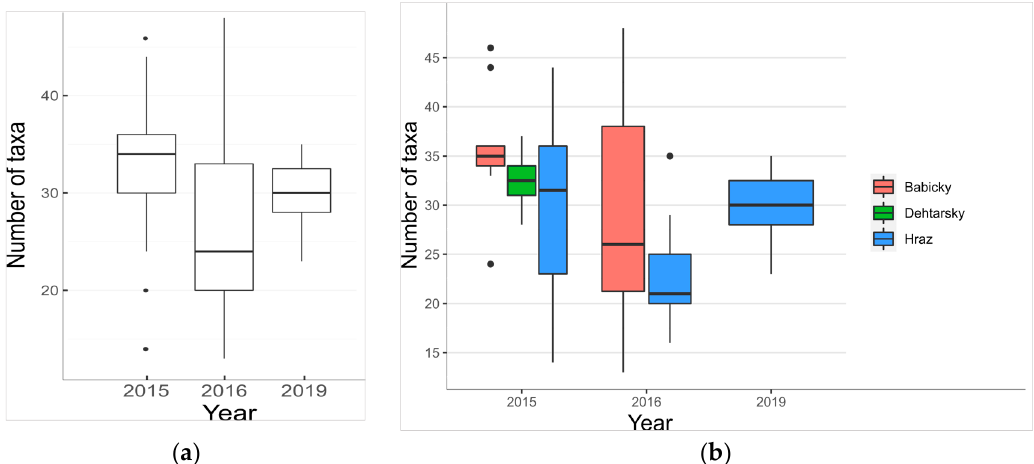
Figure 9. Comparison of diatom species richness in the Dehtá ř fishpond. ( a ) Differences between years; ( b ) differences between years and sites. Median values (horizontal lines), lower and upper quartiles (boxes, i.e., 50% of the observed values), 5% and 95% percentiles (whiskers, i.e., 90% of the observed values), and outliers (points, i.e., the values outside the 90% range) are displayed.